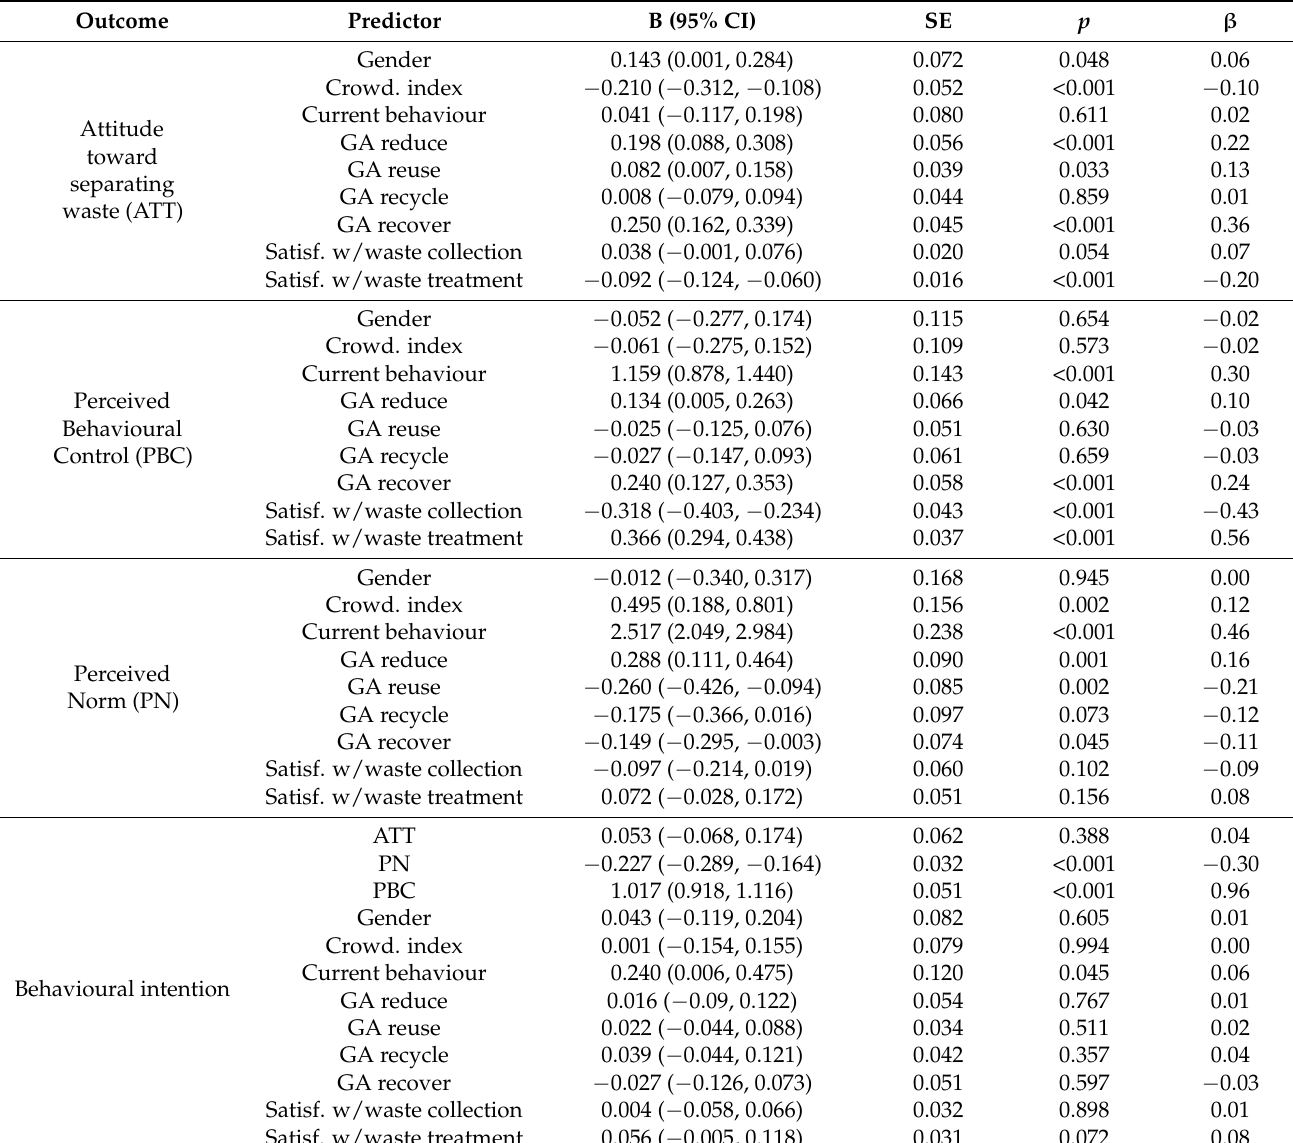
Table A1. Regression coefficients of the TPB model predicting behavioural intention ( n =